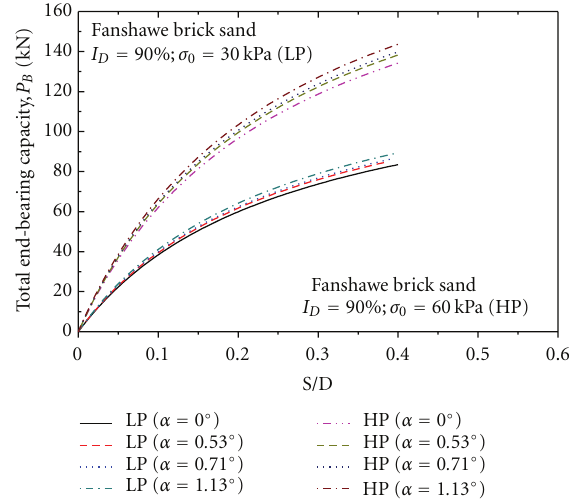
Figure 6: Total end-bearing capacity of Fanshawe brick sand of dif- ferent piles at normalized settlement